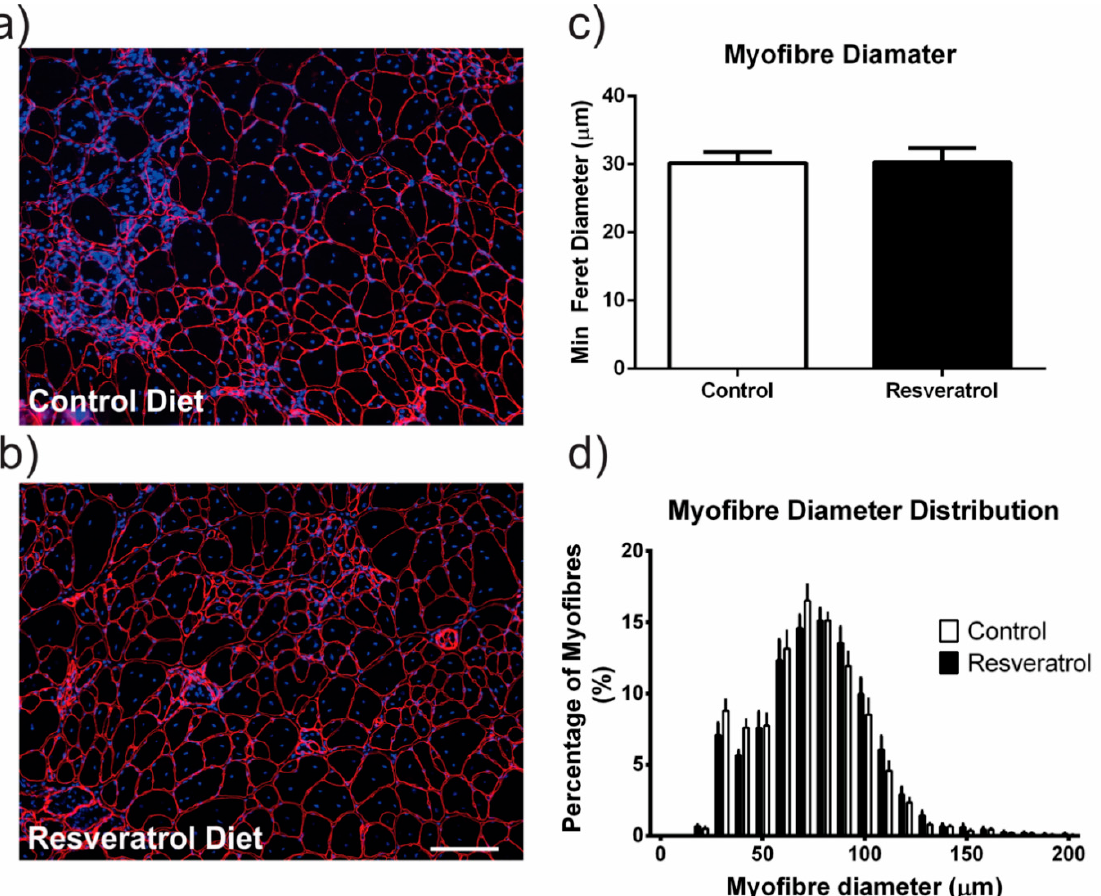
Figure 2. Frozen mdx quadriceps sections were stained with laminin α 2 (red) and Hoechst (blue). ( a ) Representative image of a stained quadriceps from an mdx mouse on the control diet. ( b ) Representative image of a resveratrol treated mdx mouse quadriceps. ( c ) The average myofibre diameter within the mdx quadriceps muscle is unchanged with resveratrol treatment when compared to the controls. ( d ) The myofibres were grouped into 10 µ m intervals and the proportion of myofibres in each interval was plotted in a histogram. There was no change in myofibre distribution with resveratrol treatment. The white scale bar indicates 200 μ m. Graphs show mean ± SEM. n = 5 for each treatment group.